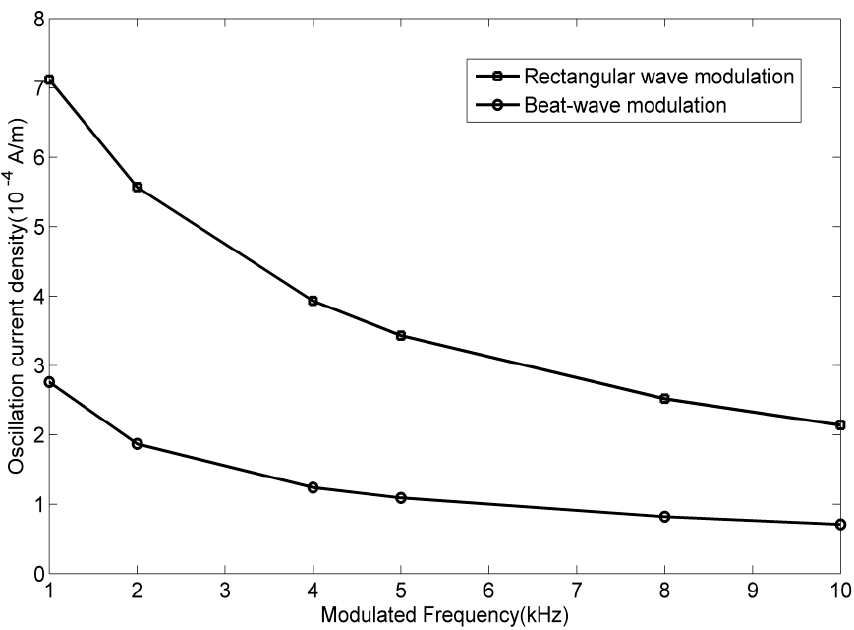
Figure 2. Our simulation results of oscillating current magnitudes modulated by rectangular wave modulation (AM) and BW modulation with the same parameters as Figure 1.